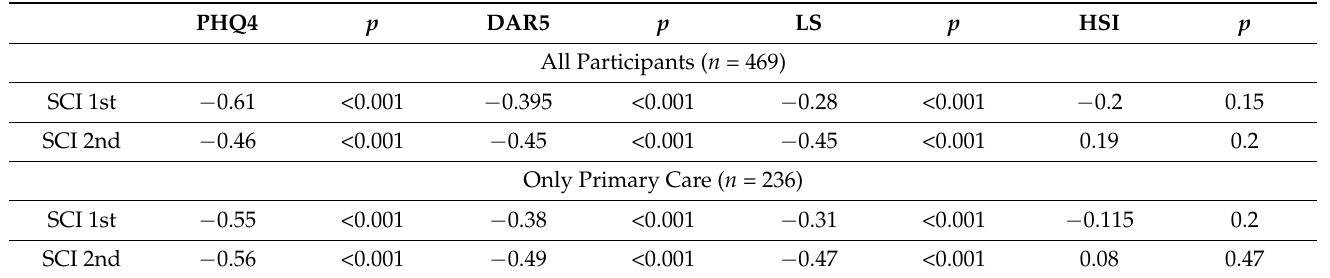
Table 6. Correlation of sleep quality with mood changes, anger and loneliness during the two waves. Analysis of all participants and separately for primary